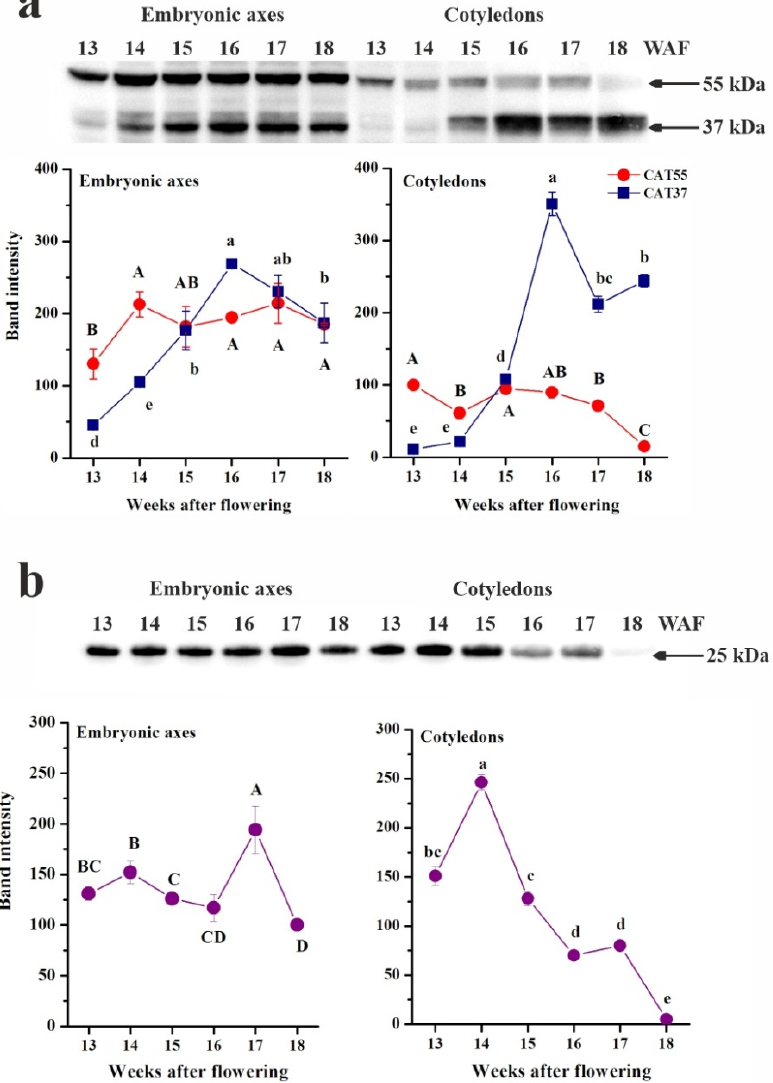
Figure 6. Immunoblot and densitometric analyses of catalase ( a ) and ascorbate peroxidase ( b ) in the embryonic axes and cotyledons of developing beech seeds. Data are shown as the means ± standard deviation ( n = 3). The same letters indicate groups that are not significantly different according to Tukey’s test.